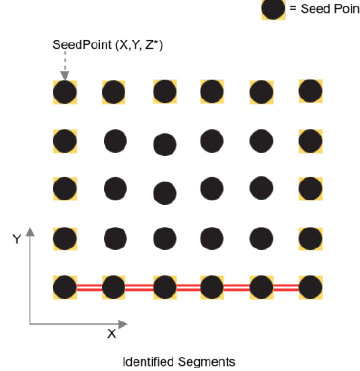
Figure 7. Extracted segment shown in Red (Top